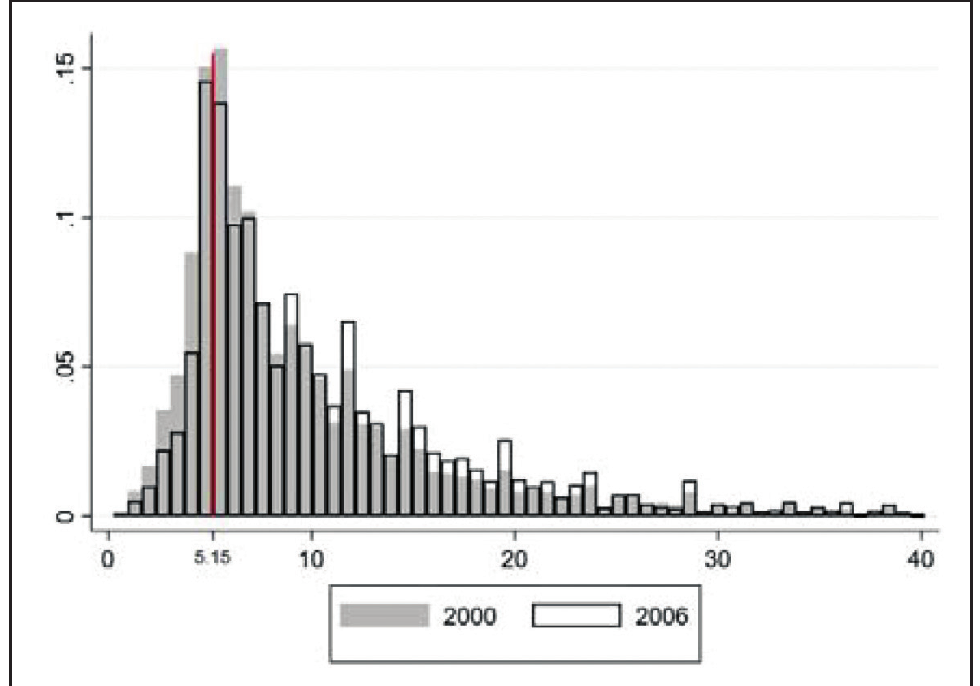
Figure 2 Distribution of Wages in Puerto Rico in 2000 and